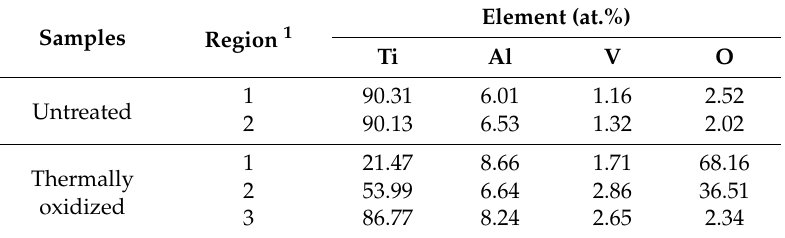
Table 4. The atomic concentration of unworn and worn surface of different samples by EDS. Samples Region 1